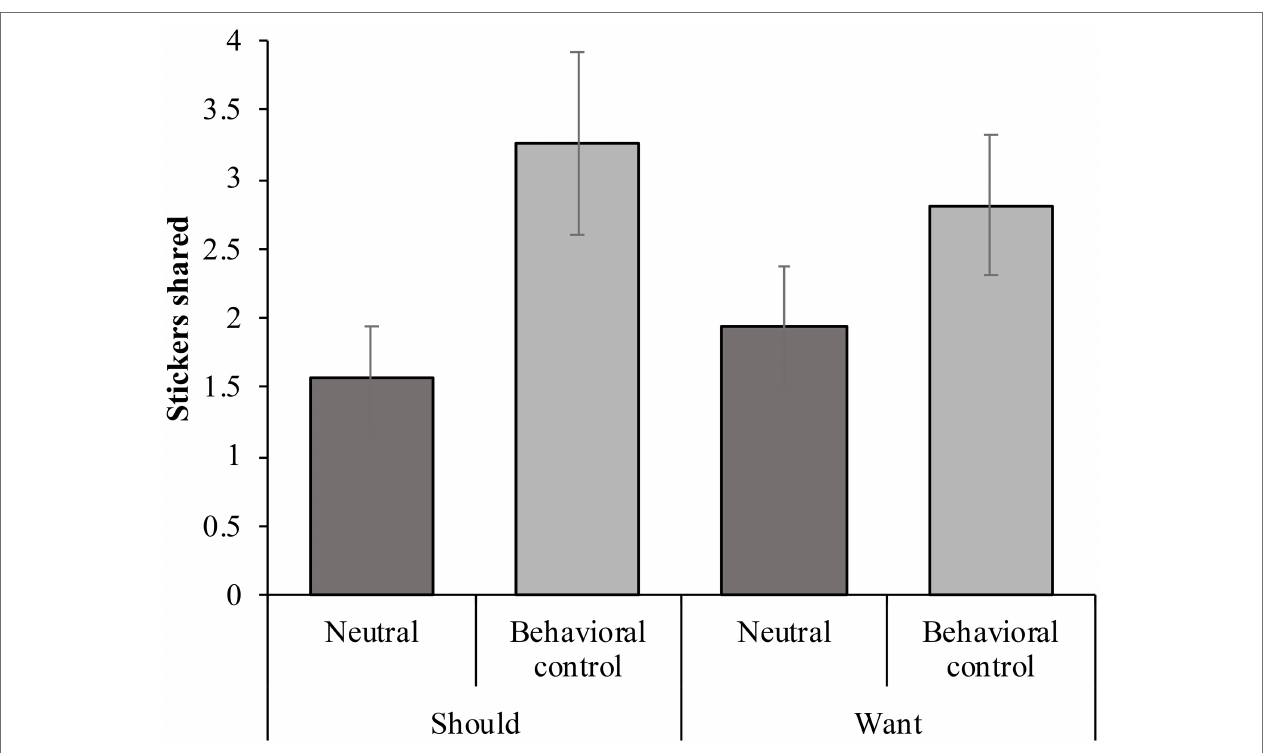
FIGURE 2 | The mean number of stickers children shared during the dictator game per condition and sharing instruction. Error bars represent